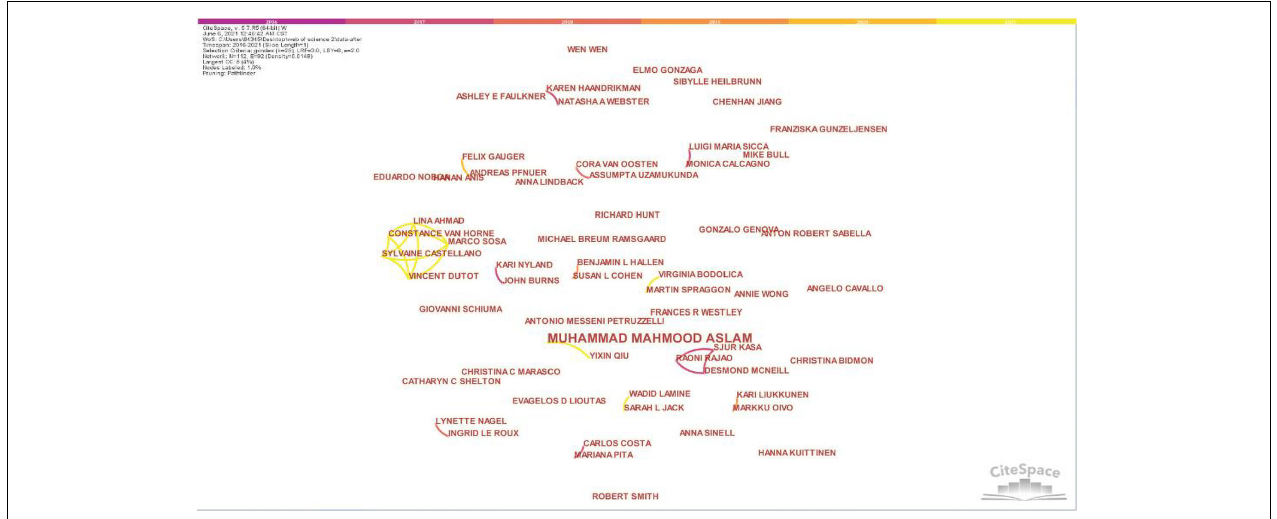
FIGURE 1 | The analysis of the author’s knowledge map drawn by CiteSpace (Retrieved by our research team and screenshots).